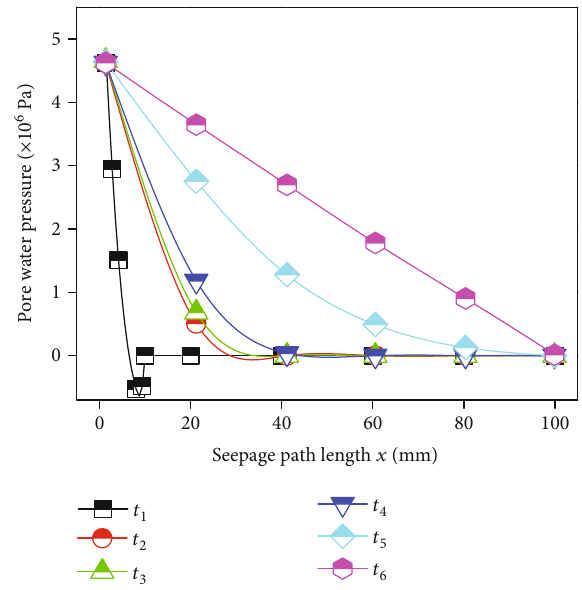
Figure 10: Relationship between pore water pressure and seepage path